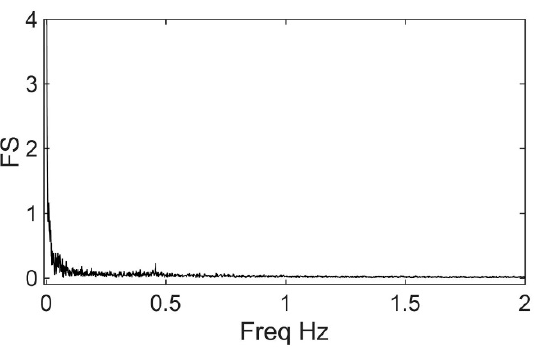
Figure 7. FFT of the plastic region of the tensile stress-time curve of the Al–0.5 wt. % Mg–20 wt. % A206/1.0 wt. % γ Al 2 O 3 wires tested at 0.500 mm/min.